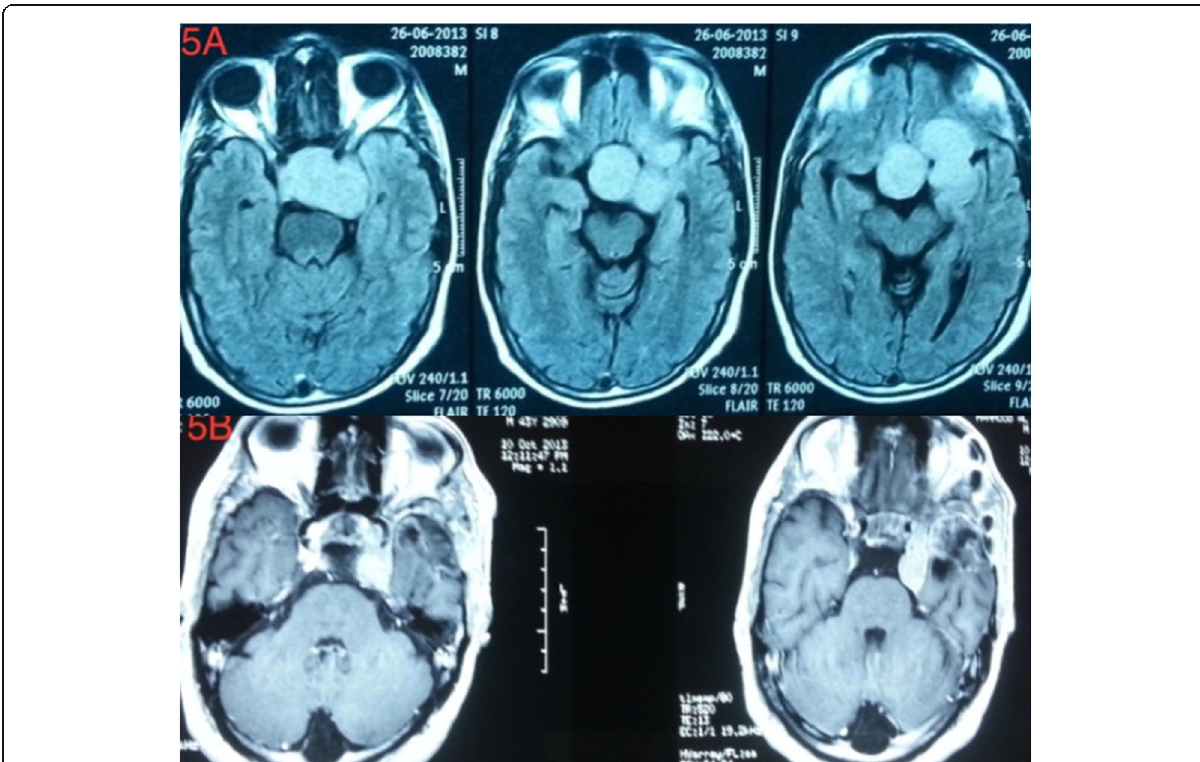
Fig. 5 A Preoperative MRI Brain showing lateral tumor extension into and lateral to the cavernous sinus. B Postoperative MRI Brain showing subtotal tumor resection leaving a small residual in the left cavernous